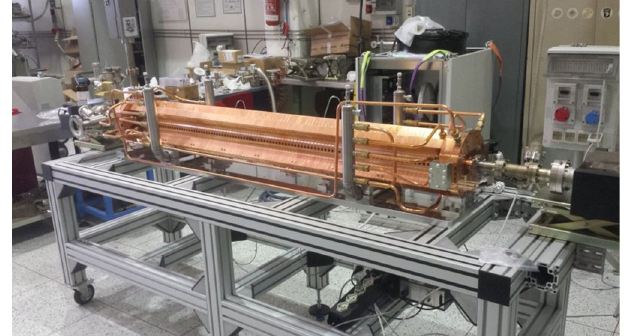
FIG. 9. C -band structure with the cooling system installed and under